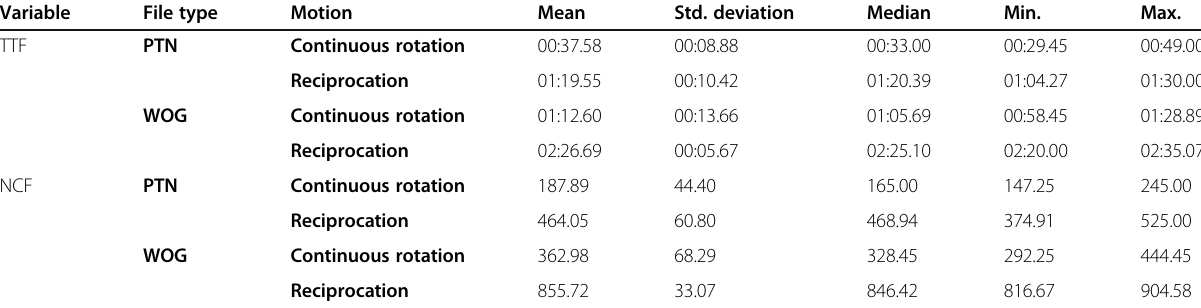
Table 2 Descriptive statistics for time till fracture (TTF) (mm:ss:ss) and number of cycles till fracture (NCF) for different groups Variable